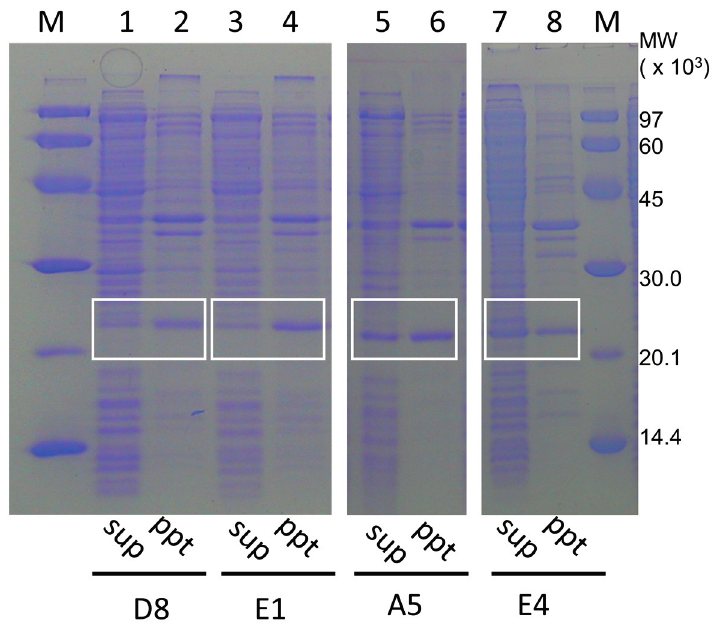
Figure 5. Examples of the solubility of PH0471 chimeric proteins containing various intrinsically disordered proteins (IDPs) acquired from the human genome. (Lanes 1 – 4 ) Examples of the PH0471 chimera with typical solubility. (Lanes 5 – 8 ) Examples of the PH0471 chimera with increased solubility. (Lanes 1 , 3 , 5 , and 7 ) Proteins from the supernatant of the whole bacterial extract. (Lanes 2 , 4 , 6 , and 8 ) Proteins from the pellet. (Lanes M , molecular weight marker). The bands containing chimeric PH0471 proteins are indicated by white